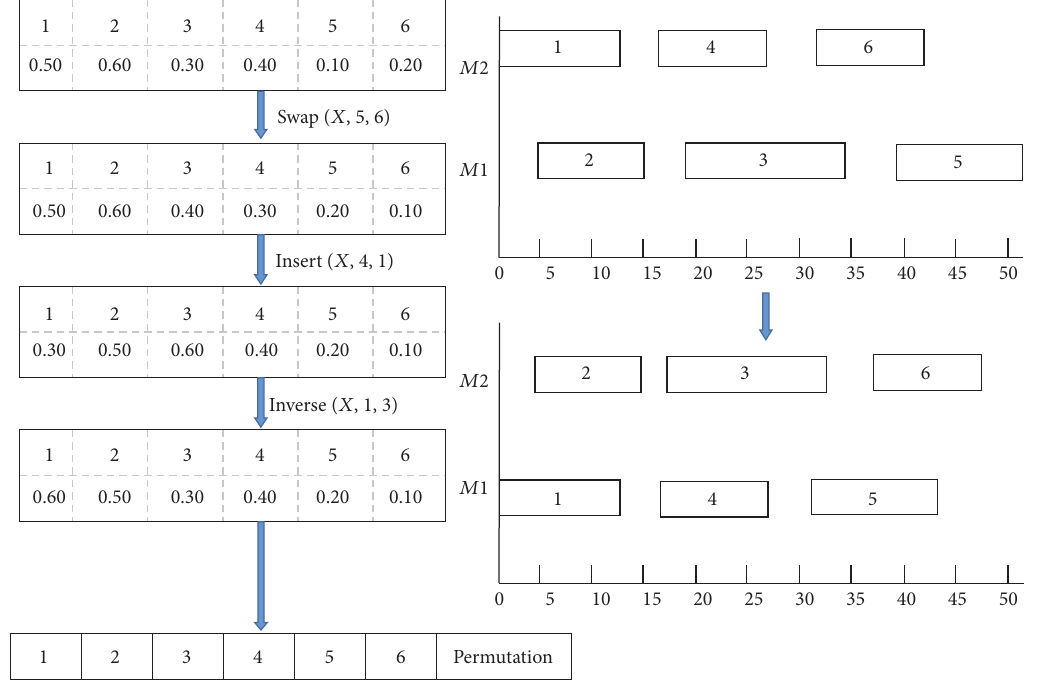
Figure 4: An illustrative example for local search Strategy